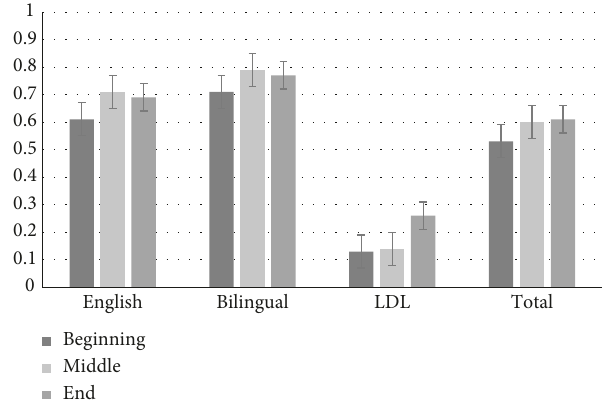
Figure 2: Means and standard errors for WER II (flawed T-unit: contains all the main critical structures but has one or more surface errors) at the beginning, middle, and end of the year by language groups.